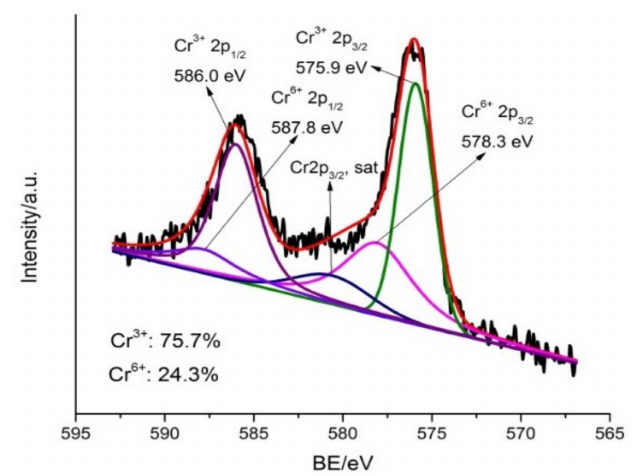
Figure 10. XPS spectra of Cr 2p for MSB300 after Cr(VI)